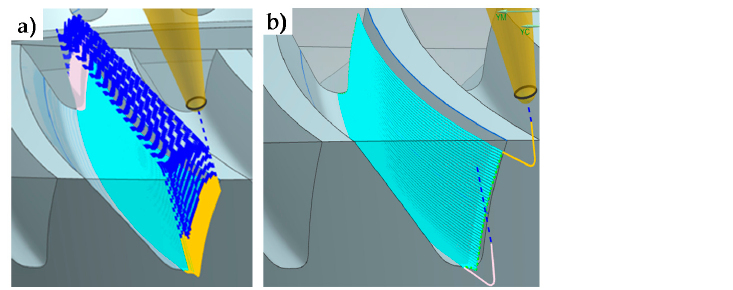
Figure 3. Finishing strategies. F-I ( a ) 3 + 2 finishing strategy. F-II ( b ) 5 continuous axes finishing strategy.